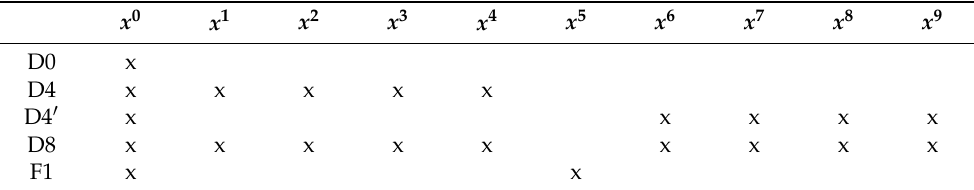
Table 4. Brane set-up associated to the solutions (24) and (25). x 0 is the time direction of the ten dimensional spacetime; x 1 , . . . , x 4 are the coordinates spanning CY 2 ; x 5 is the direction where the F1-strings are stretched; and x 6 , x 7 , x 8 , and x 9 are the coordinates where the SO ( 4 ) R-symmetry is realised. x